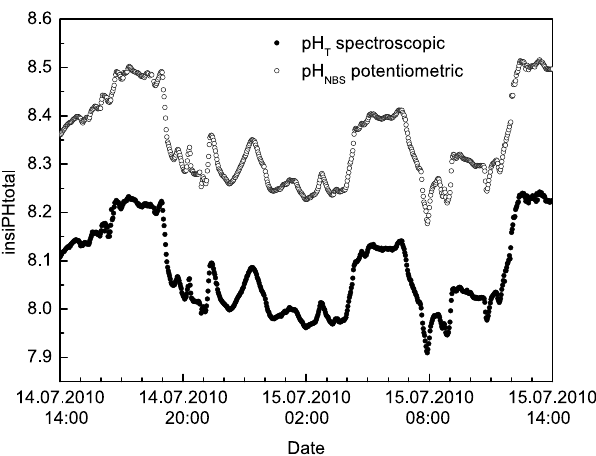
Fig. 8. Comparison of the optically (total scale) and potentiometri- cally (NBS scale) measured pH values for a selected period of 24h with intense pH variations. pH values at NBS scale are measured at in-situ temperature, while pH values at total scale are converted to in-situ temperature. The average offset is 0.27pH units. The last calibration of the glass electrode up to that point was more than a week earlier.